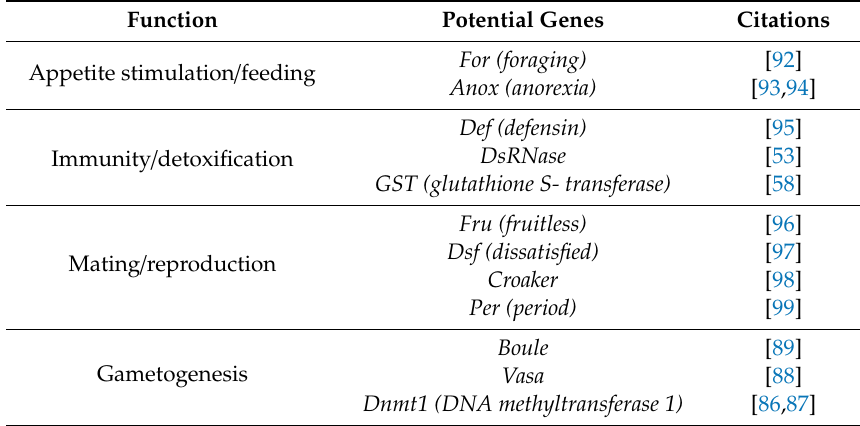
Table 1. Examples of potential sublethal genes as targets of RNAi pest